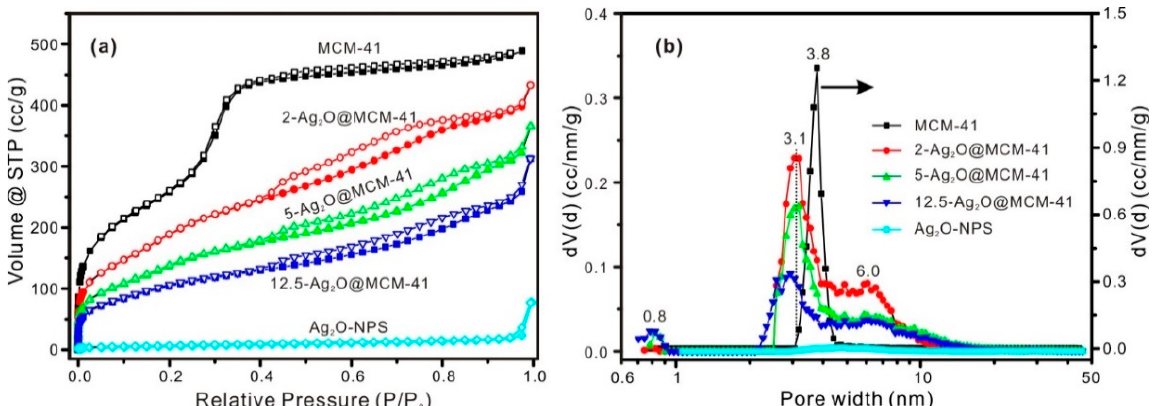
Figure 3. ( a ) N 2 adsorption-desorption isotherms and ( b ) PSD curves of the MCM-41 support, the Ag 2 O@MCM-41 nanomaterials (for MCM-41, the y -axis is on the right; for the other samples, the y -axis is on the left), and the Ag 2 O-NPS.